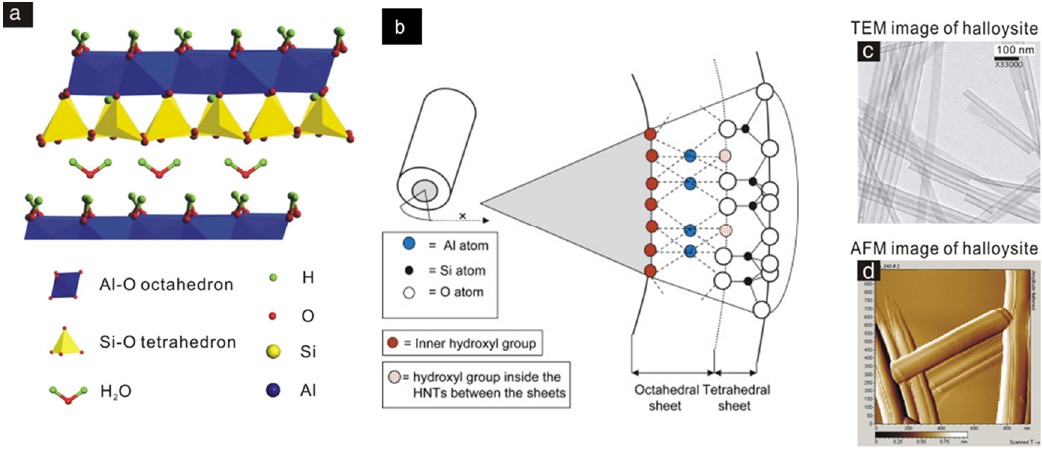
Figure 1. ( a , b ) HNTs crystal morphology and atomic structure; ( c , d ) Trasmission electron microscopy (TEM) and (Atomic force microscopy) AFM images of HNTs. Adapted with permission from [1,2].